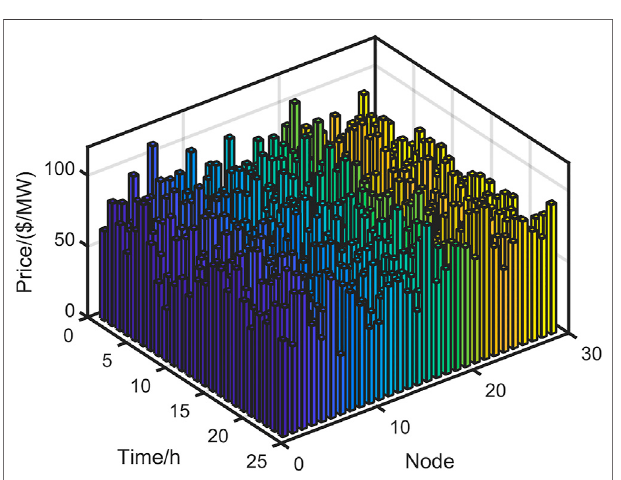
FIGURE 6 | The distribution of LMP in scenario 2.